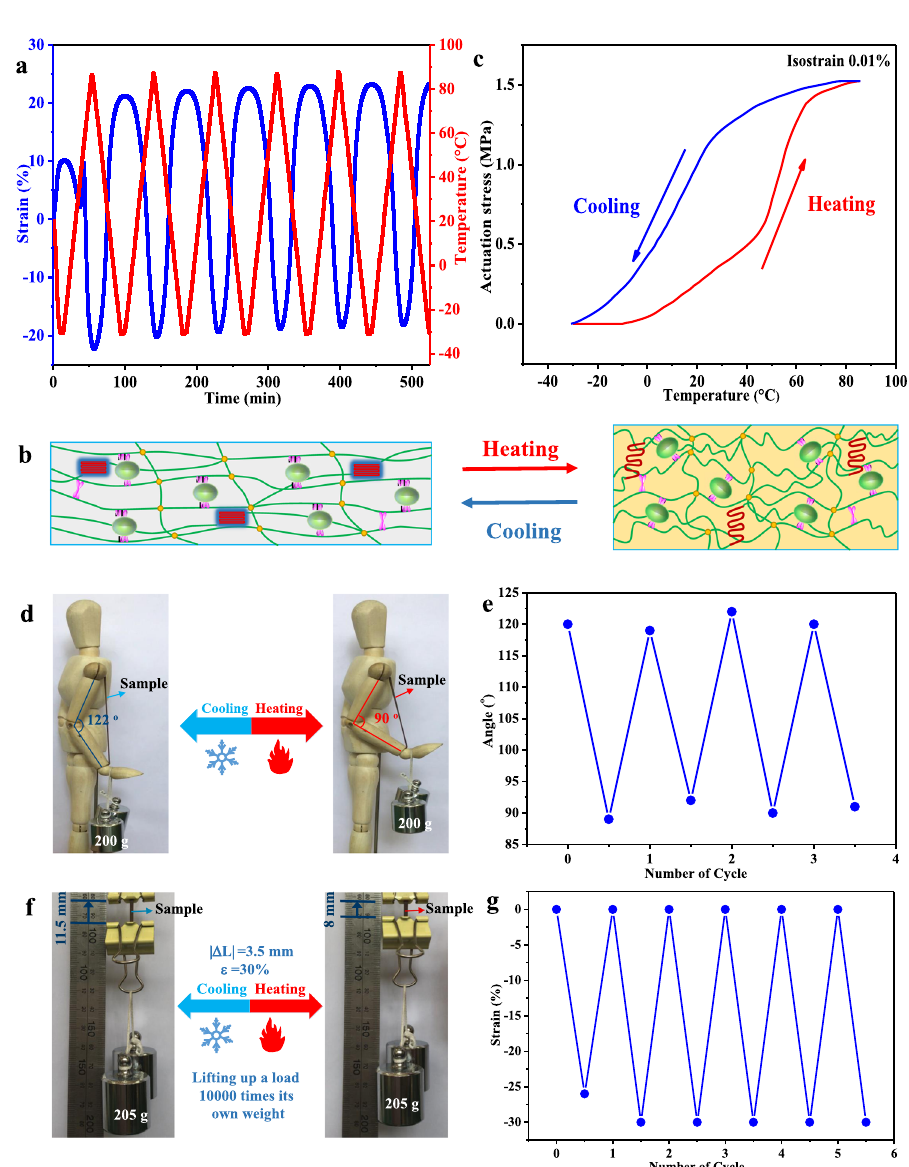
plotted against time. b Schematic graph of reversible actuation effect of EPDM composites after mechanical training. c Stress variation in isostrain mode of L40Z12@600% plotted against temperature. d Photographs of the angle change and e plot of the angle change vs cycles for the thermal actuation of L40Z12@600% lifting up a 200 g load ( fi re represents heating and ice represents cooling). f Photographs of the length change and g plot of the